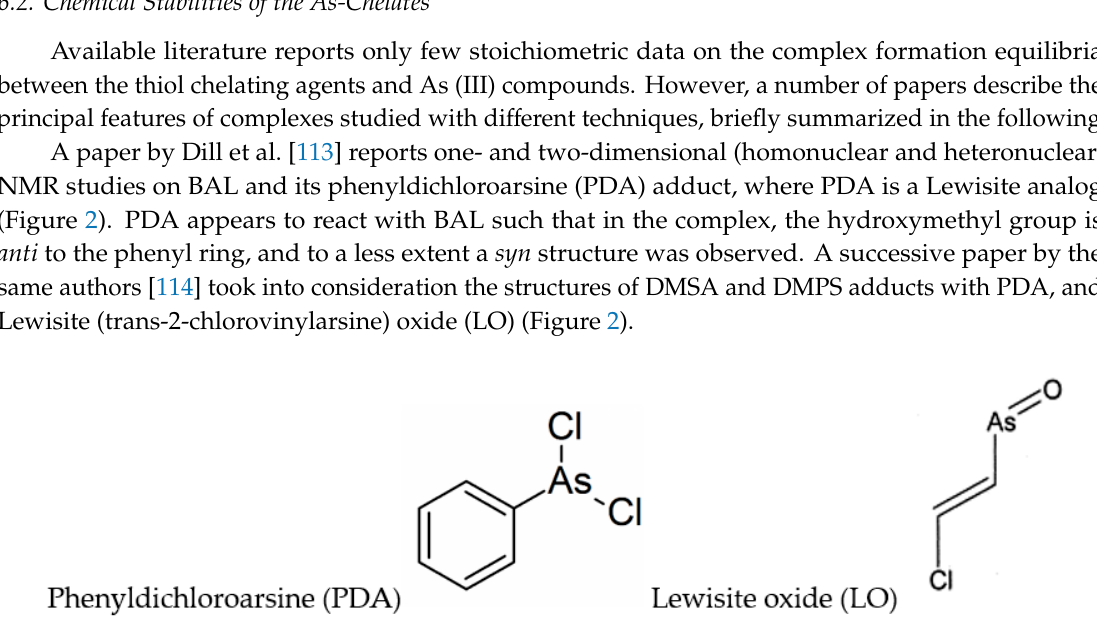
Figure 2. Chemical formulae of phenyldichloroarsine (PDA) and Lewisite oxide (LO).